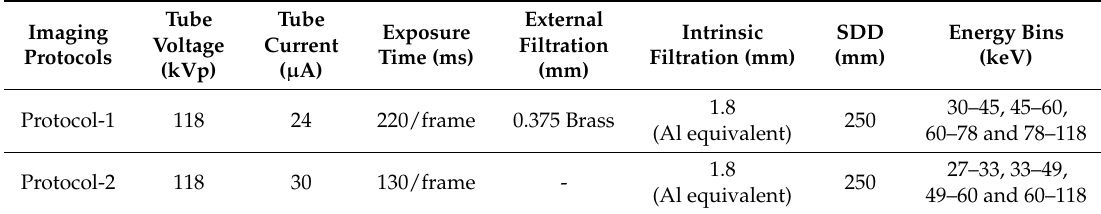
Table 1. Imaging parameters of two